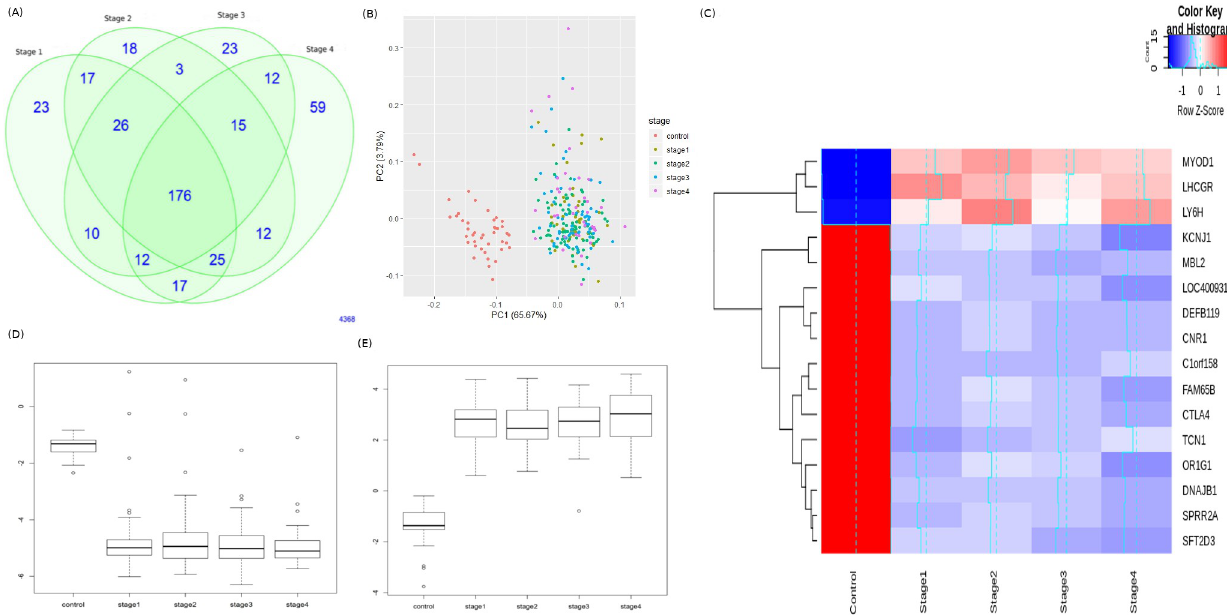
Fig 3. Linear modelling with M-value matrix, avereps transformation. (A) Venn distribution of significant DM genes in each stage relative to control. (B) Distribution of samples based on the top two principal components of the top 100 genes shows a clear separation of cancer cases (labelled by stage) and controls. (C) Stagewise methylation portraits of the top four significant stage-specific DMGs. The stark contrast with the control is especially evident. Also shown are the stagewise methylation levels of (D) NALCN, and (E) GLRX. https://doi.org/10.1371/journal.pone.0249151.g003 Mutations in NALCN have been reported in sporadic CRC [44]; here NALCN is seen to be sig- nificantly hypermethylated, indicating the same outcome (loss of function) could be effected in multiple ways. GLRX is a target of the activating transcription factor MEOX2 [45]. It is observed that LY6H showed both hypermethylation and hypomethylation when compared to the controls, indicating the role of experimentation necessary to clarify its role in colorectal cancer progression. The top significant 100 genes of each stage, listed in S4 File in S1 Text, were used for the consensus analysis.